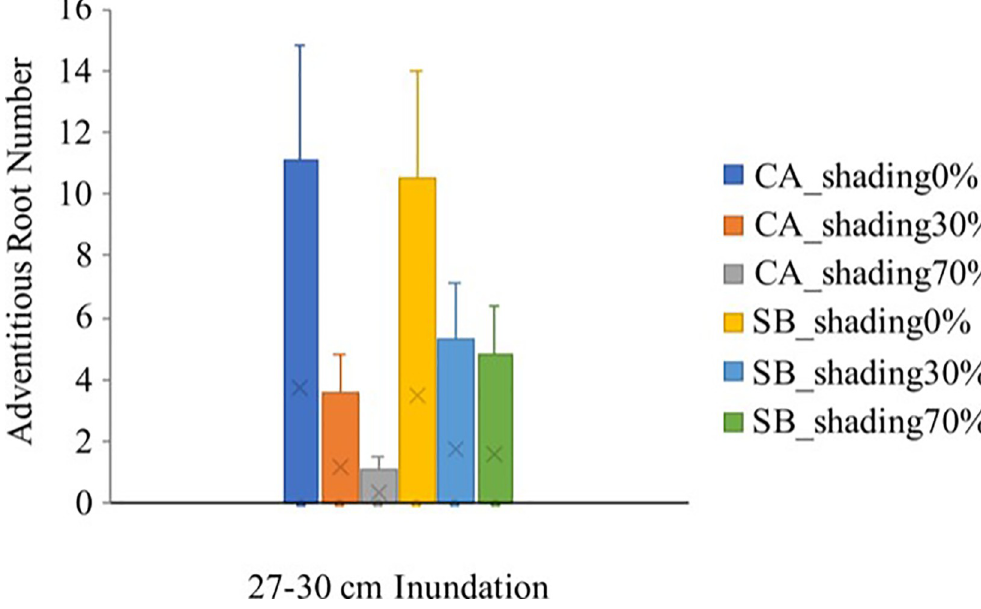
Fig 4. Number of adventitious roots on C . arborescens (CA) and Shorea Balangeran (SB) at 3 levels of shading and ⅓ stem height flooding.